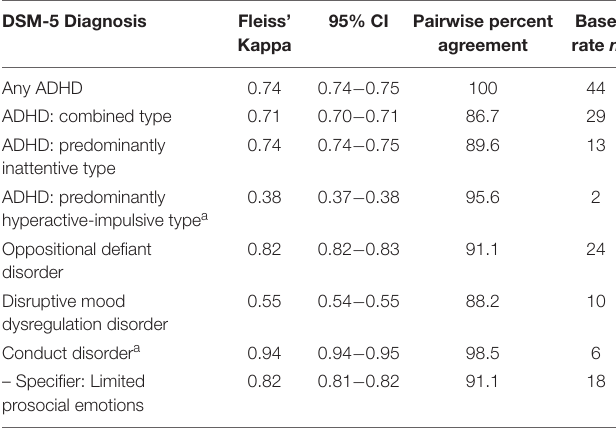
TABLE 4 | Agreement on DSM-5 diagnoses in the subsample for the analysis of interrater